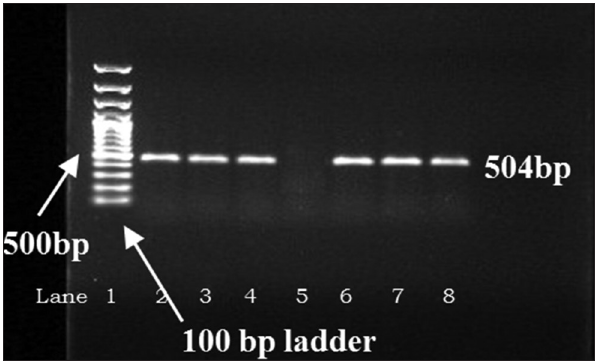
Figure-4: Detection of exo S gene (504 bp) in Pseudomonas aeruginosa isolates by polymerase chain reaction. Lane 3-4, 6-8: Test samples, 2: Positive control, 5: Negative control.